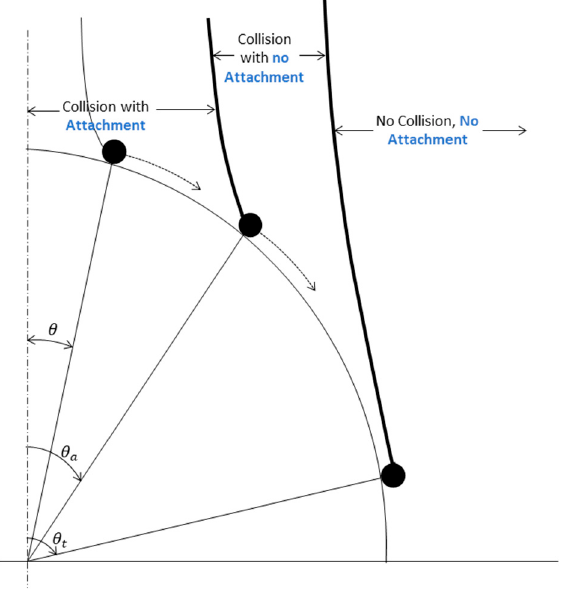
Figure 2. Schematic of different angles involved in particle–bubble attachment, modified from [47].